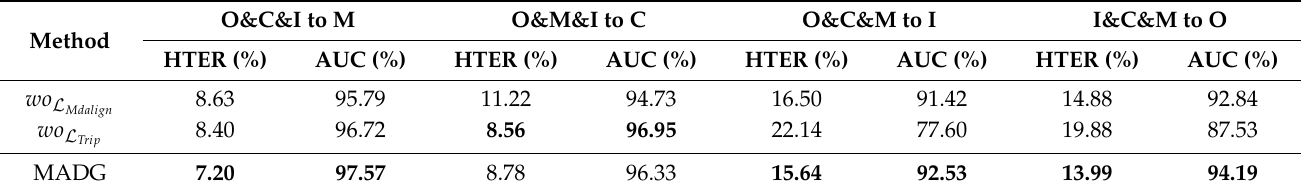
Table 4. Ablation study of different components of the proposed method. The header is the task protocol and the bold represents the optimal